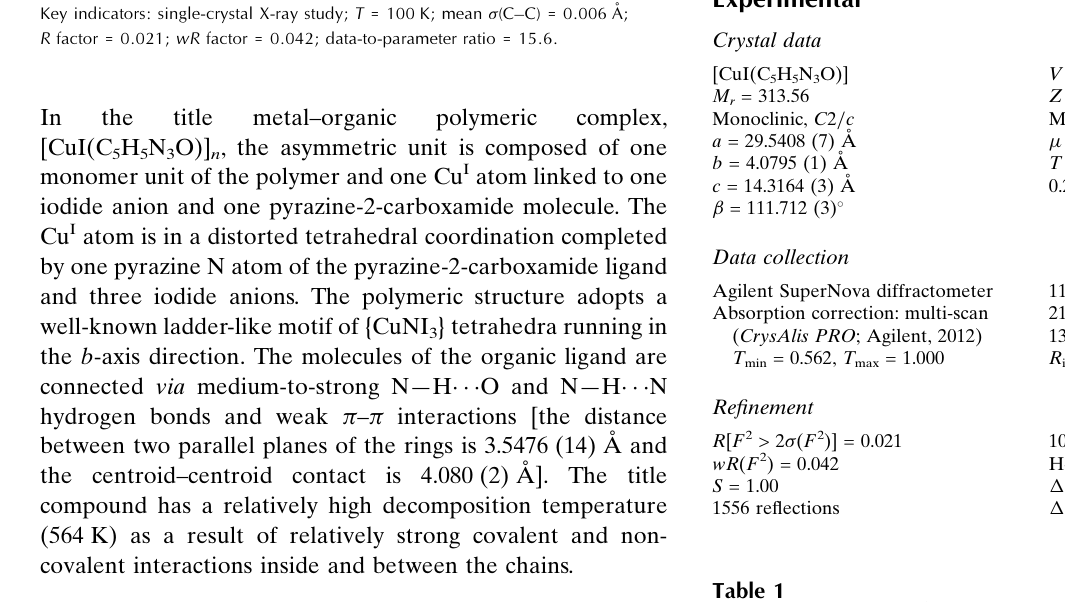
Selected bond lengths (A˚ ).